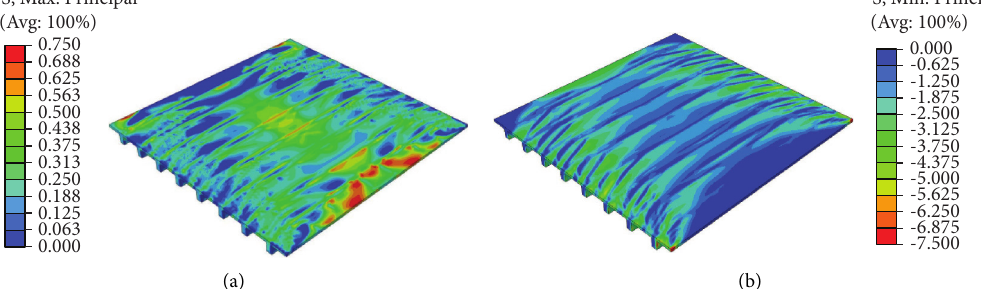
Figure 12: Distribution of main maximum and minimum stresses for a model with loading in X direction (MPa) at displacement equivalent to maximum strength. (a) Maximum principal stress distribution in concrete slab (MPa). (b) Distribution of minimum stress in concrete slab (MPa).